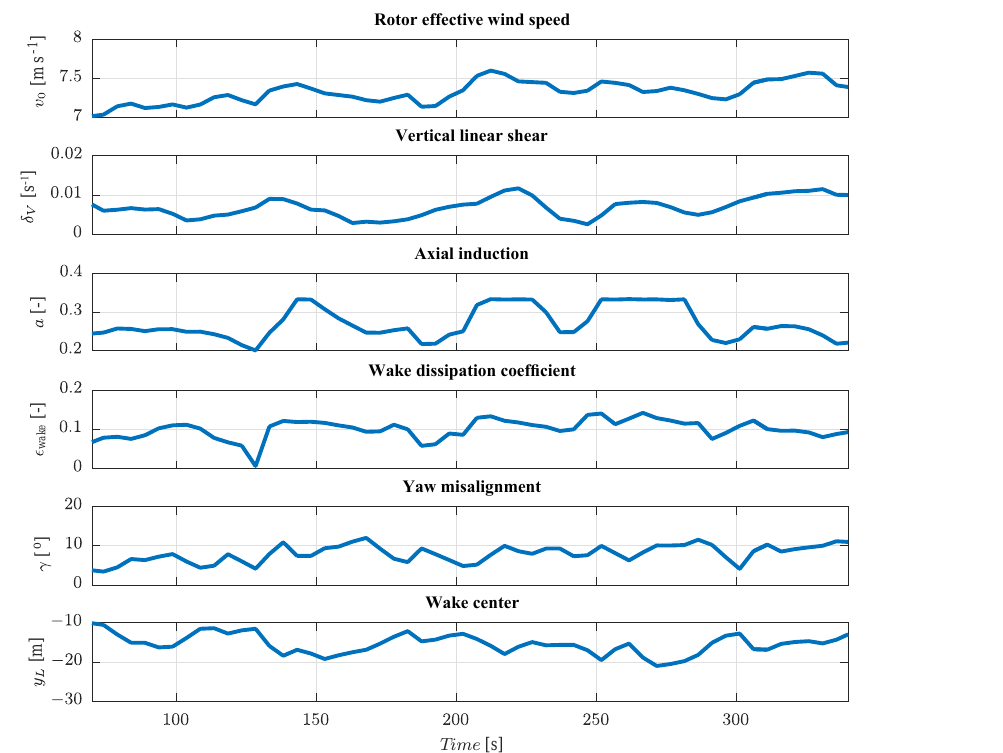
Figure 9. A second time evolution of the different estimated wind field and wake quantities. In this case, the wind turbine is misaligned with 30 ◦ and the wake is deflected. The lidar scanned in a 7 × 7 grid at five distances from 0.6 to 1.4 D . The wake center is estimated at the furthest scanning distance 1.4 D = 176.4m.